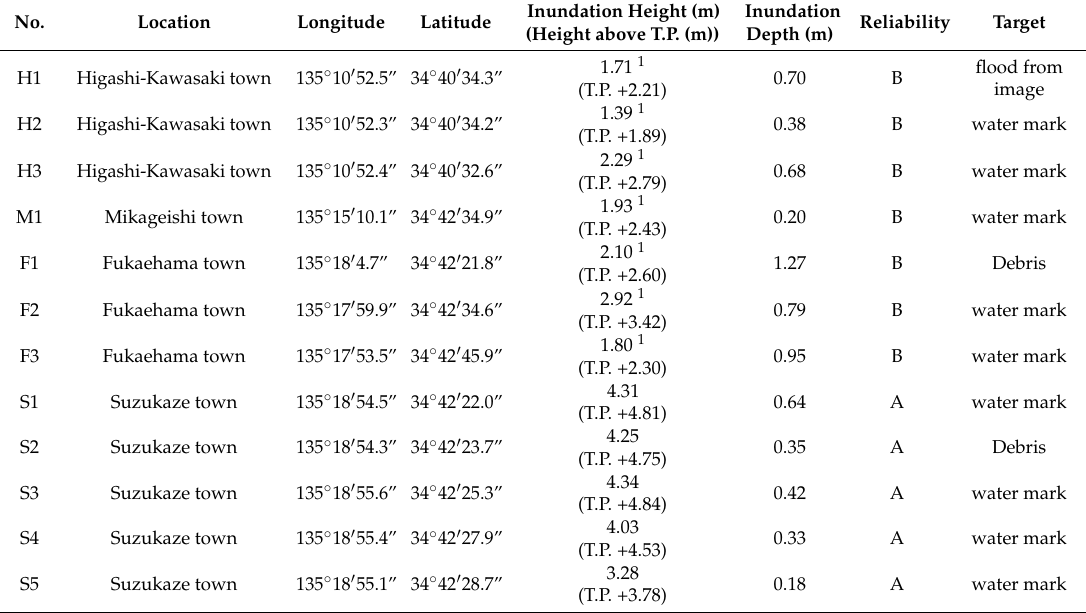
Table 2. Survey measurement results. Inundation height is defined as the height above the local tide level during the event, while inundation depth is defined as height from the local ground level. The reliability of the measurements is classified into A, B, C, and D. A: clear mark and small possible survey error; B: unclear mark and small possible survey error; C: unclear mark and large possible survey error; and D: unclear mark, low confidence, and large possible survey